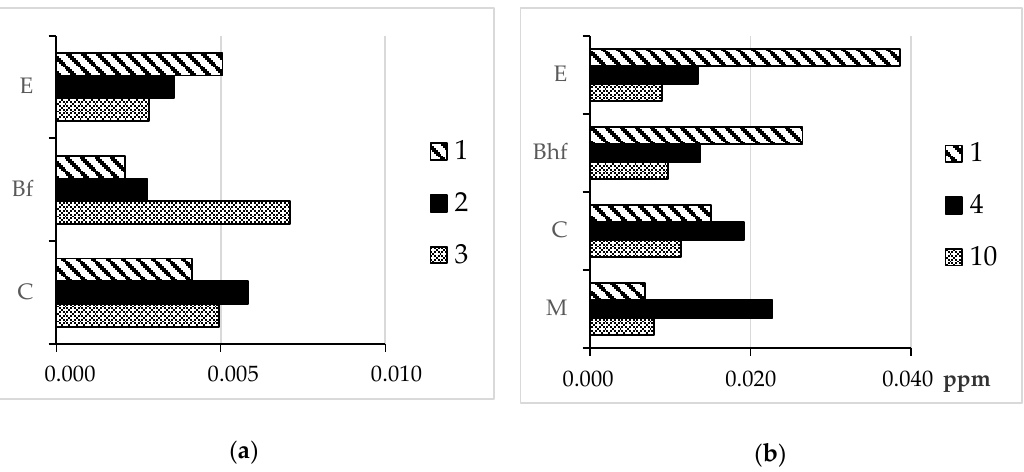
Figure 3. The changes of gold’s mobile form concentration in the studied soil horizons within different profiles: ( a ) 1—over the mineralized zone, 2—over the circum-ore zone, 3—out of the mineralized zone; ( b ) 1,4,10—profiles in the Piilola prospecting